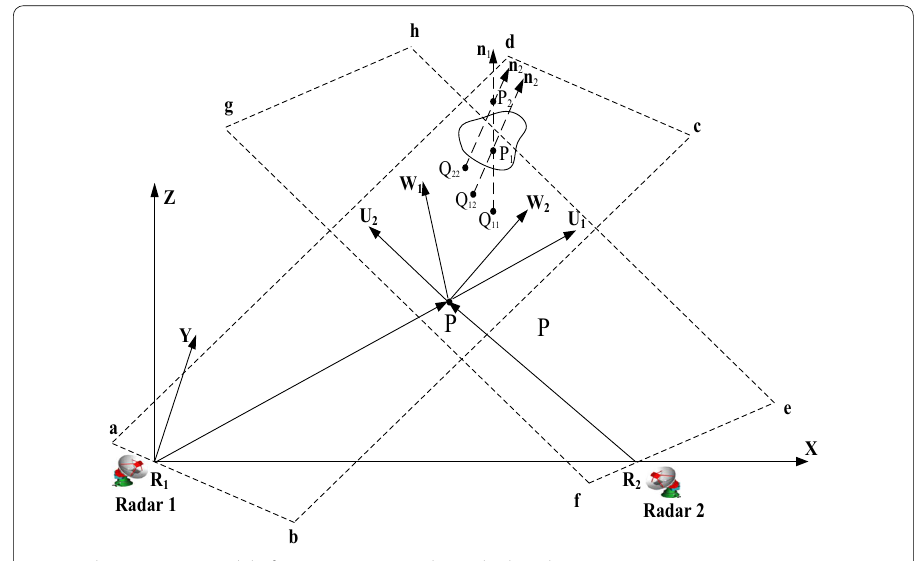
Fig. 2 The geometry model of projection process by multiple